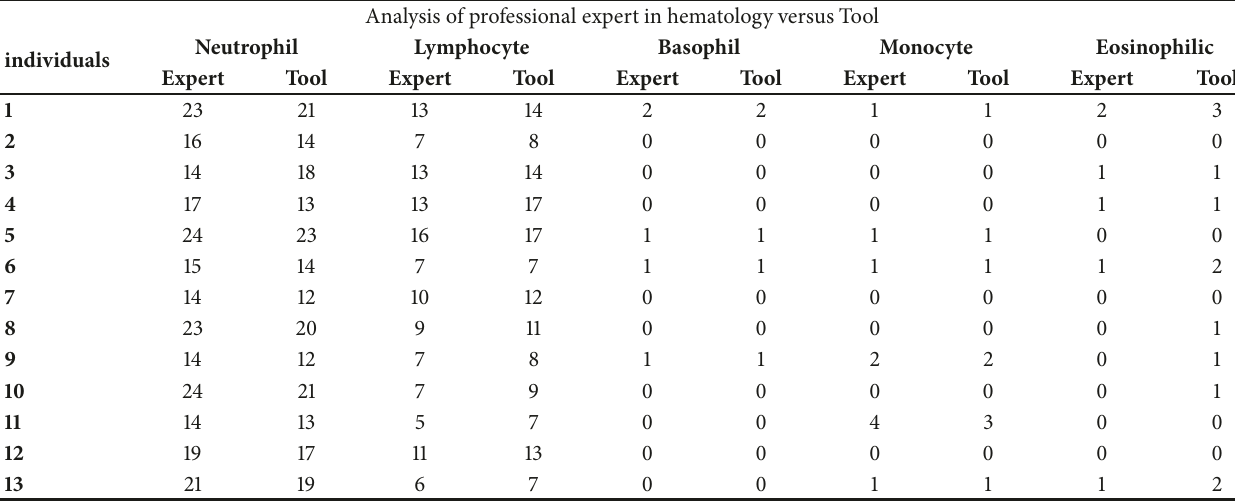
Table 2: Analysis of the smears of blood performed by the professional in hematology versus computational tool. Analysis of professional expert in hematology versus Tool